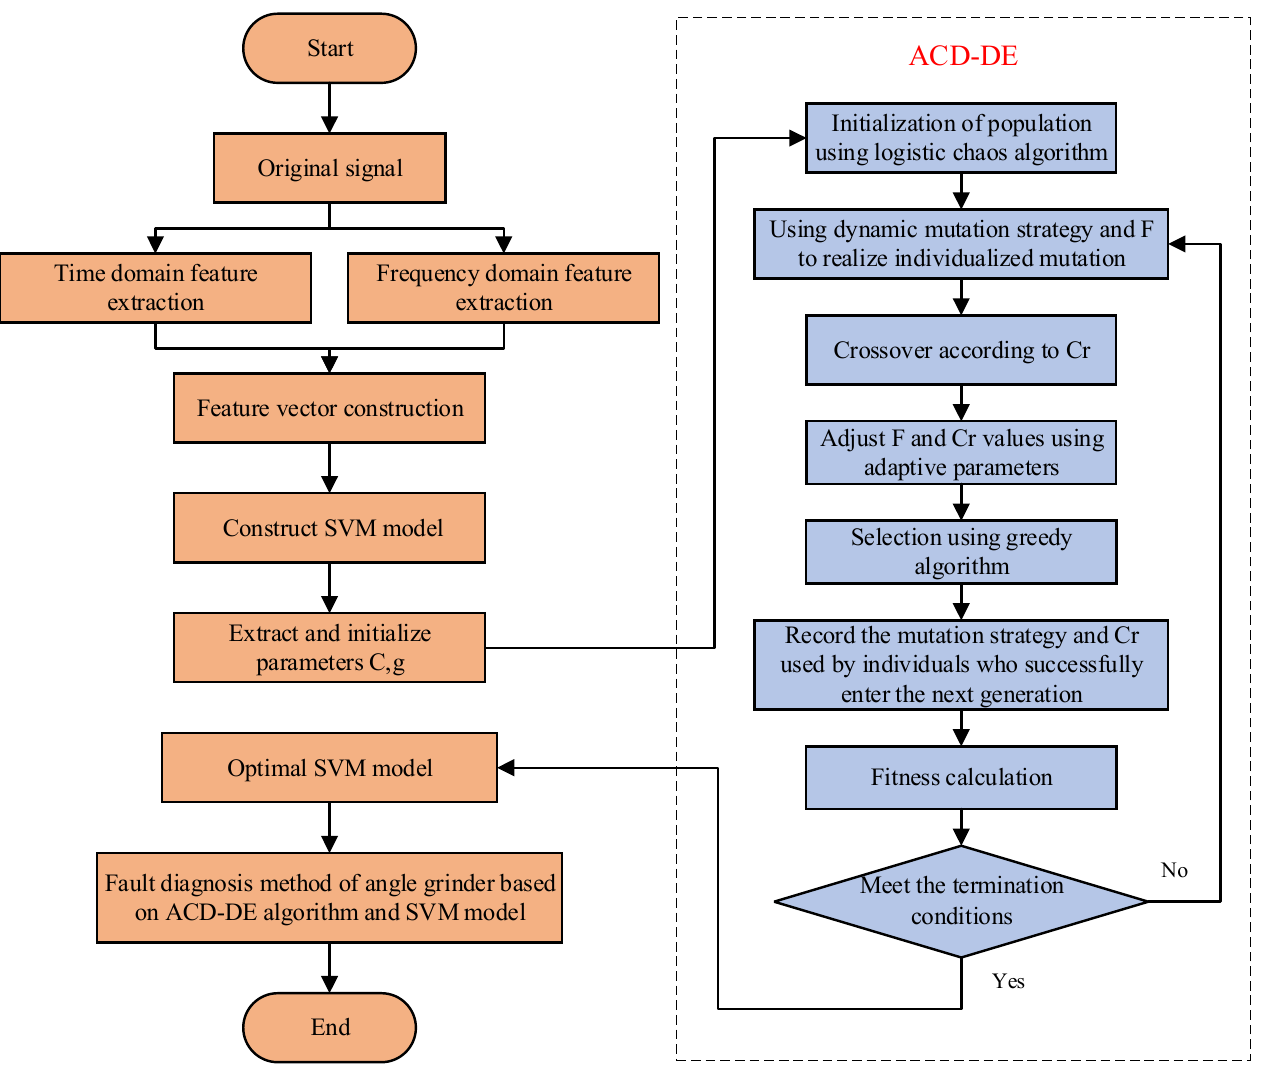
Figure 1. Flow chart of fault diagnosis method of angle grinder based on ACD − DE algorithm and SVM model.